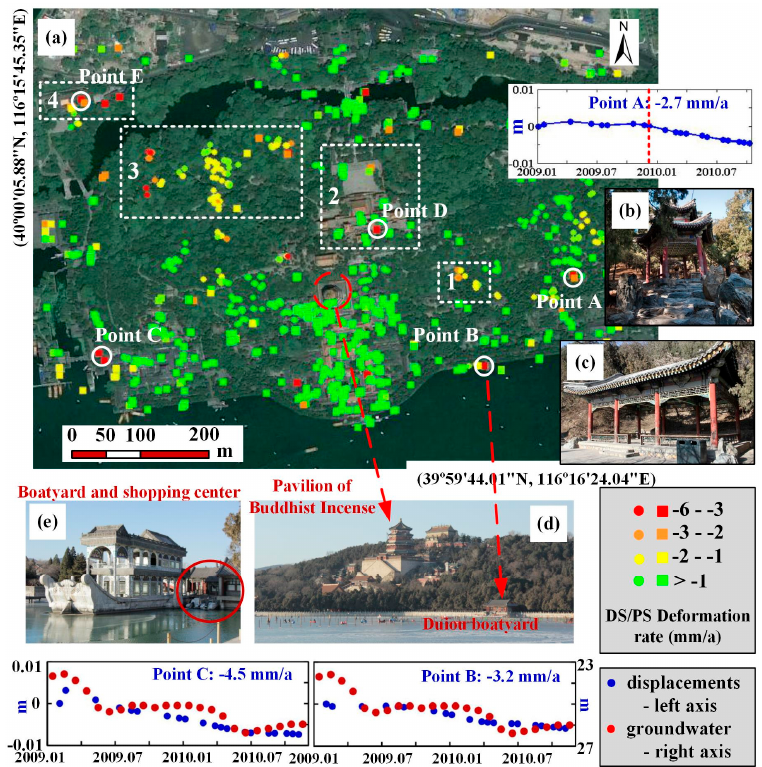
Figure 5. ( a ) Map of deformation rates of the Longevity Hill superimposed on the Google Earth image. Four typical regions (from Region 1 to Region 4) and five points (A–E) with significant motions are shown; ( b – e ) Photographs of Point A, Region 1, and Points B and C obtained during field campaigns, respectively. The three graphs illustrate displacement evolution (blue dots) of Points A–C; the red dashed line in the evolution of Point A was used to mark the starting time of subsidence. Groundwater data (red dots) were used to validate the motion evolutions of Points B and C.